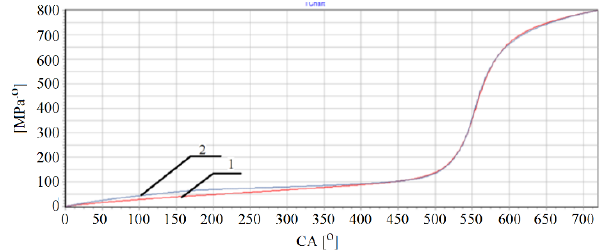
Fig. 3. The course of the indicated pressure integral curves obtained as a result of model tests – 1 and empirical tests – 2 as a function of the angle of rotation of the